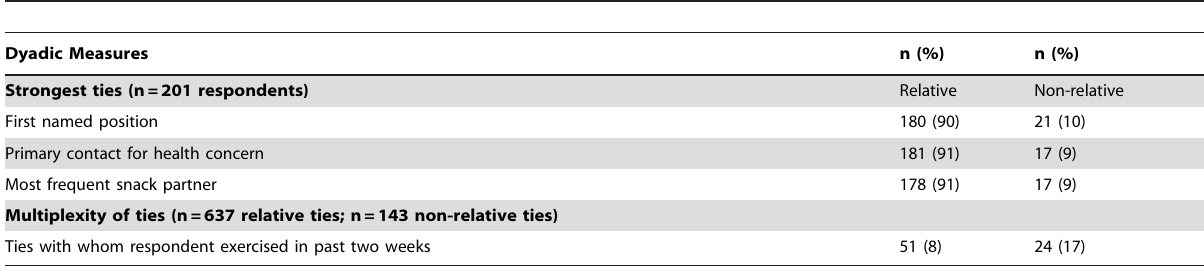
Table 4. Exemplary dyadic features of ties reported by respondents in New Delhi, India.